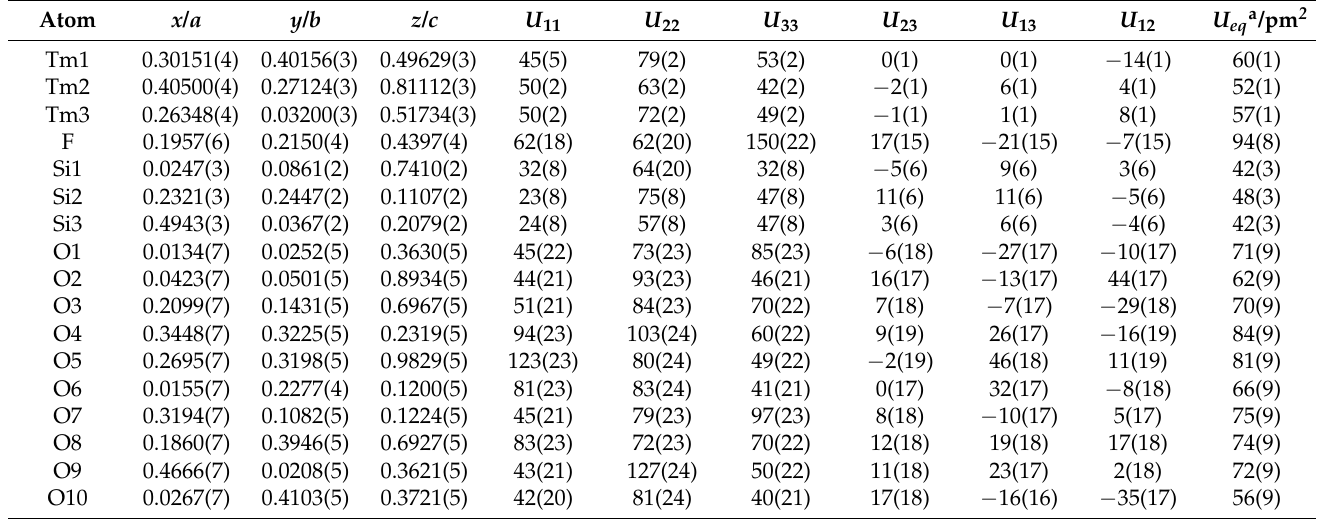
Table 2. Atomic parameters and coefficients of the anisotropic thermal displacement factors ( U ij /pm 2 ) for Tm 3 F[Si 3 O 10 ] (all atoms reside at the Wyckoff position 4 e ).